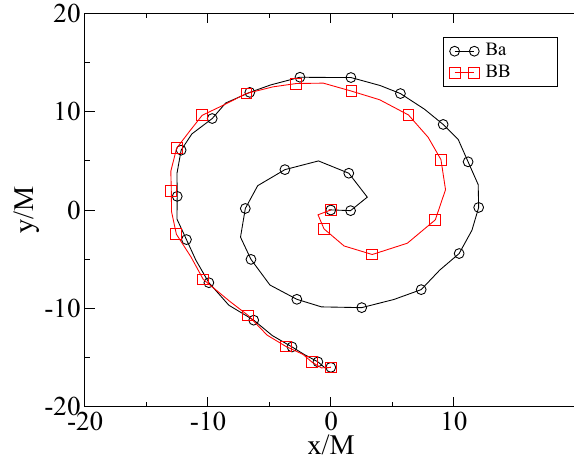
Fig. 19 The position of the center of one BS within an orbiting binary as a function of time for the two cases: (i) [B-B] identical BSs and (ii) [B-poB] opposite phase pair. Notice that the orbits are essentially identical at early times (and large separations), but that they start to deviate from each other on closer approach. This is consistent with the internal structure of each member of the binary being irrelevant at large separations. Reprinted with permission from Palenzuela et al. (2008); copyright by